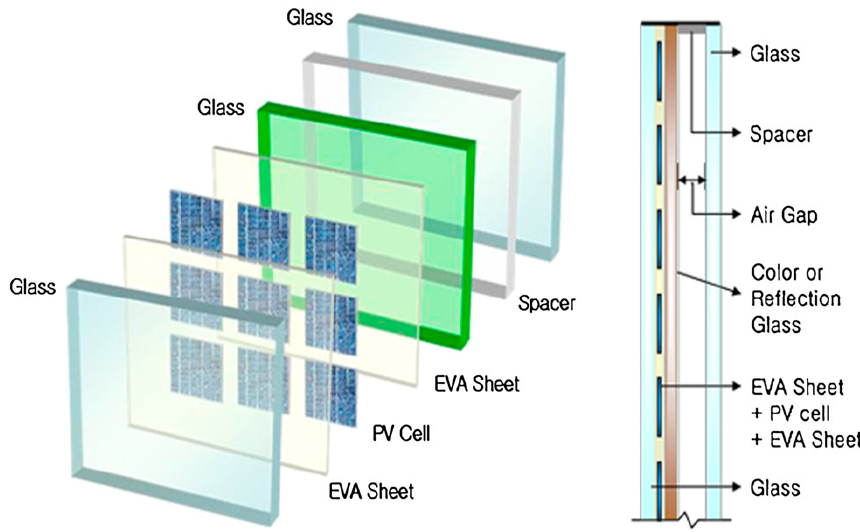
Figure 4. Different layers of the encapsulated STPV modules [18].